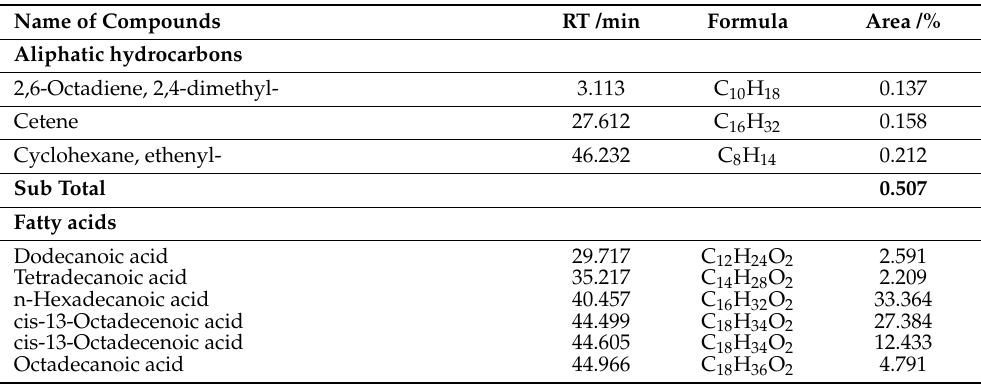
Figure 3. GC-MS chromatograms of the oil phase. Table 4. Compents of the oil phase in the cold-rolling oil sludge by GC/MS.